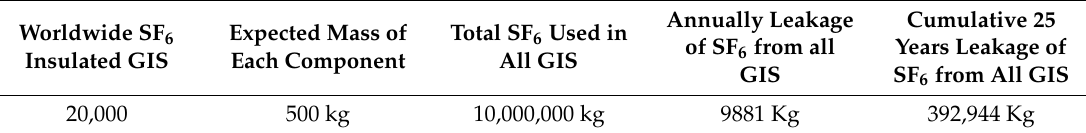
Table 2. Worldwide usage and leakage of SF 6 from all